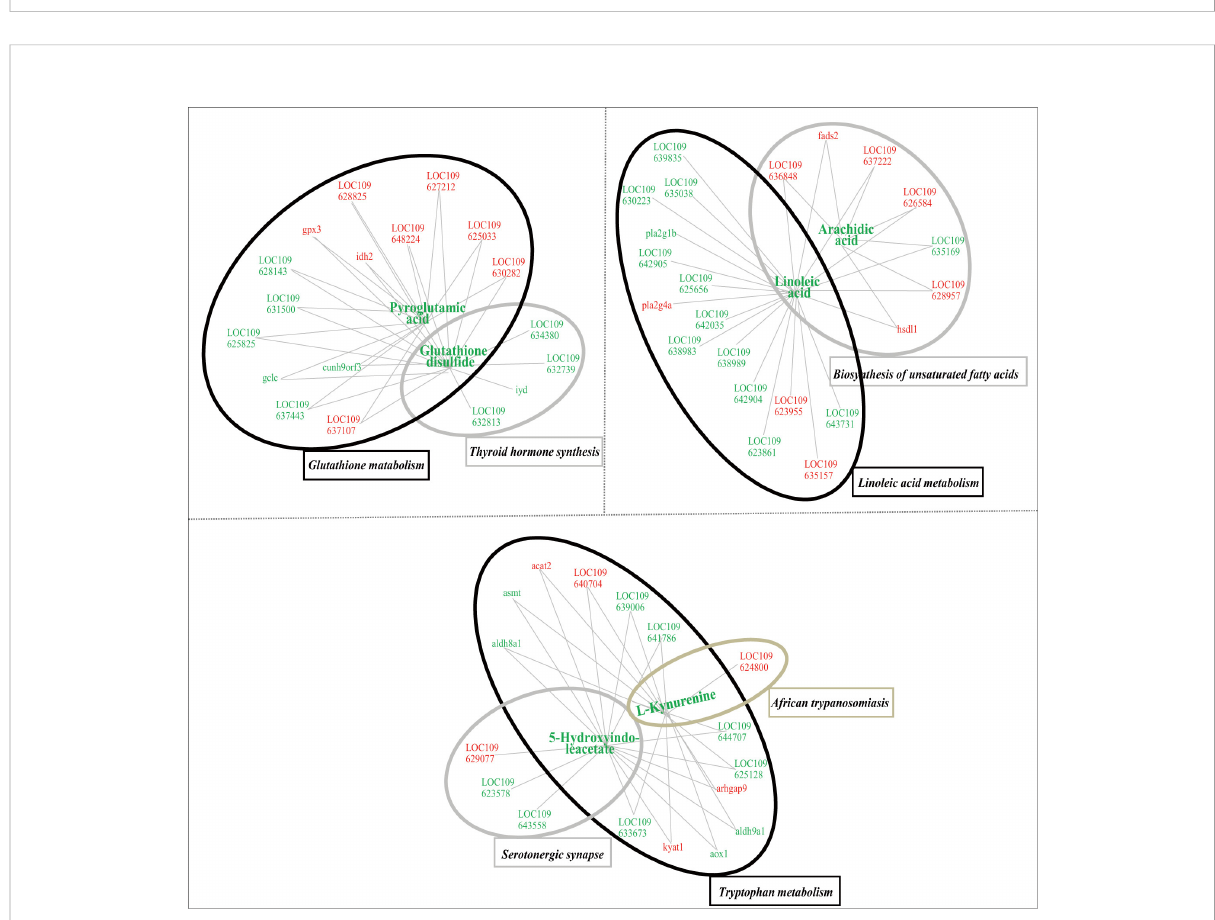
FIGURE 7 Integrated network of functional interactions between signi fi cant changed secondary metabolites and signi fi cantly differentially expressed genes, whose levels were signi fi cantly affected in the liver tissues of juvenile fl ounder after MeHg exposure. In this regard, metabolites and genes were connected if they shared at least one common KEGG pathway. Increased or decreased metabolites or genes are indicated by red and blue symbols,